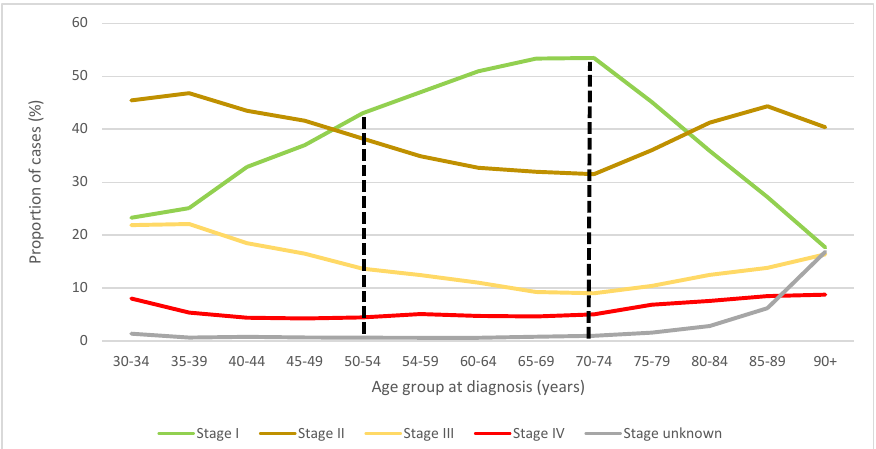
Figure 2. Stage–specific distribution of female breast cancer cases by age group at diagnosis, Canada excluding Quebec, 2010 to 2017 period. Note: Quebec is excluded because cases diagnosed in Quebec from 2011 onward had not been submitted to the Canadian Cancer Registry. The ages between the dashed lines represent those age groups for which mammogram screening is currently recommended. Source: Canadian Cancer Registry (1992 to 2018) at Statistics Canada [42].